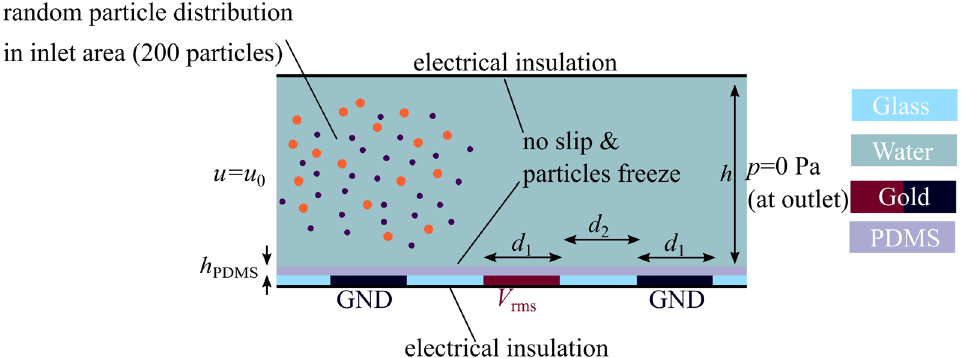
Figure 5. Important boundary conditions and materials of the simulative model. Important parameters: height of the channel h = 80 µ m, width d 1 and spacing d 2 of the electrodes is 100 µ m. Inlet velocity 8.68 mm s − 1 and insulation thickness h PDMS = 1.75 µ m. At the inlet 200 particles were randomly distributed in a 1.5 cm × 60 µ m area being 10 µ m away from bottom and